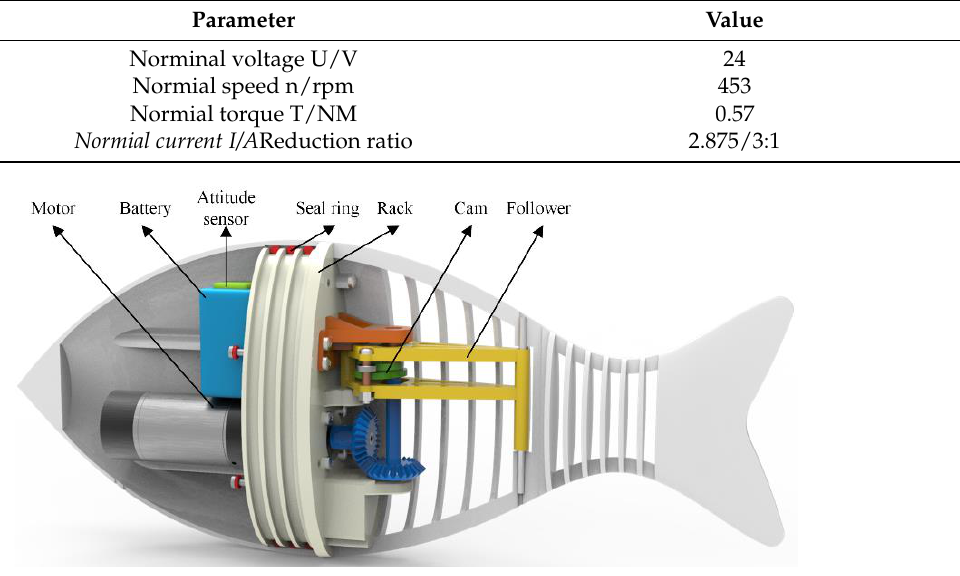
Figure 5. The structural model of the proposed robotic